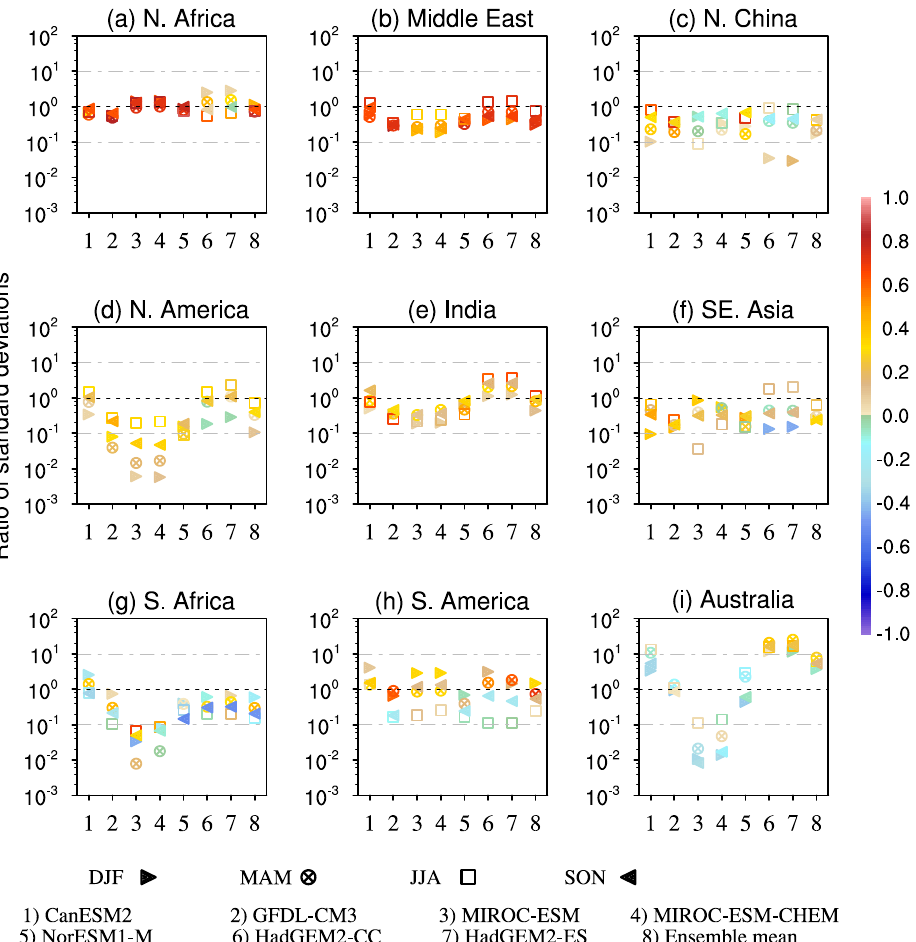
Figure 4. Spatial statistics comparing DOD from CMIP5 models with that from MODIS in nine regions. Label on the x axis shows individual models (1–7) and multi-model mean (8). y axis shows the ratio of pattern standard deviations between model climatology (2004–2016) and that of MODIS, which reveals the relative amplitude of the simulated DOD versus satellite DOD. The color denotes pattern correlation (centered) between each model and MODIS DOD in each